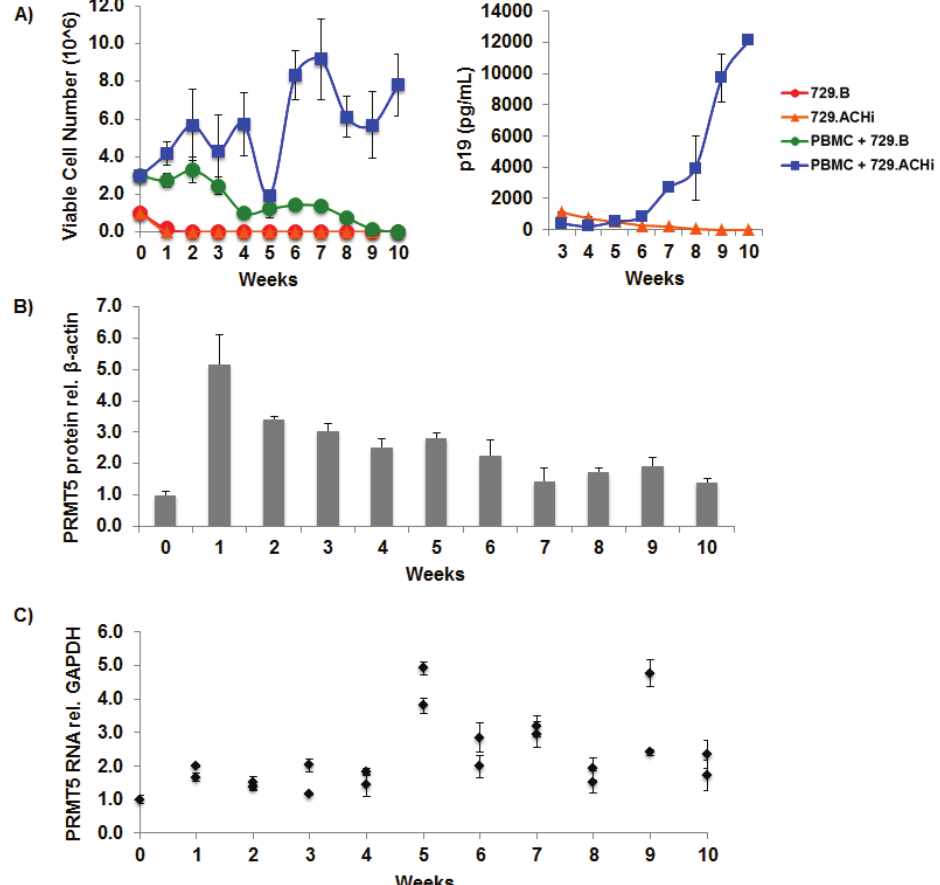
Figure 2. PRMT5 levels were elevated during HTLV-1-mediated cellular transformation. Freshly isolated PBMCs (2 × 10 6 cells) were co-cultivated with 10 6 lethally irradiated 729.B uninfected parental or 729.ACH HTLV-1-producer cells in 24-well plates. ( A ) A growth curve showing the immortalization process as measured by T-cell number and ELISA data showing p19 Gag protein production at weekly intervals are presented. Means and standard deviations of data from each time point were determined from four random independent wells; Cells were also collected at weekly intervals and analyzed by immunoblotting for PRMT5 protein expression ( B ); and qRT-PCR analysis for PRMT5 RNA levels ( C ). PRMT5 levels are shown relative to an internal control ( β -actin, GAPDH) for each time point. Resting PBMC PRMT5 levels were set to 1. Means and standard deviations of data from each time point were determined from two random independent wells.